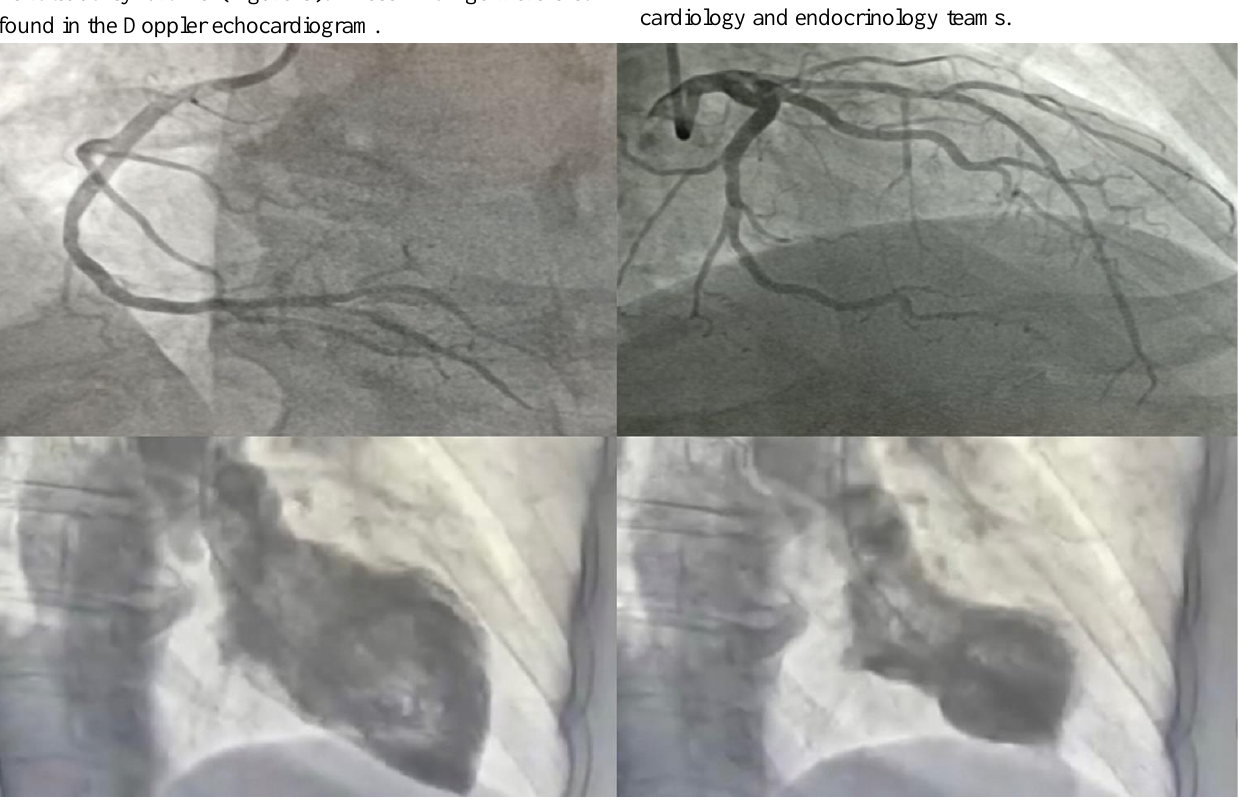
Figure 3 : Coronary angiography without significant lesions and ventriculography image of apical